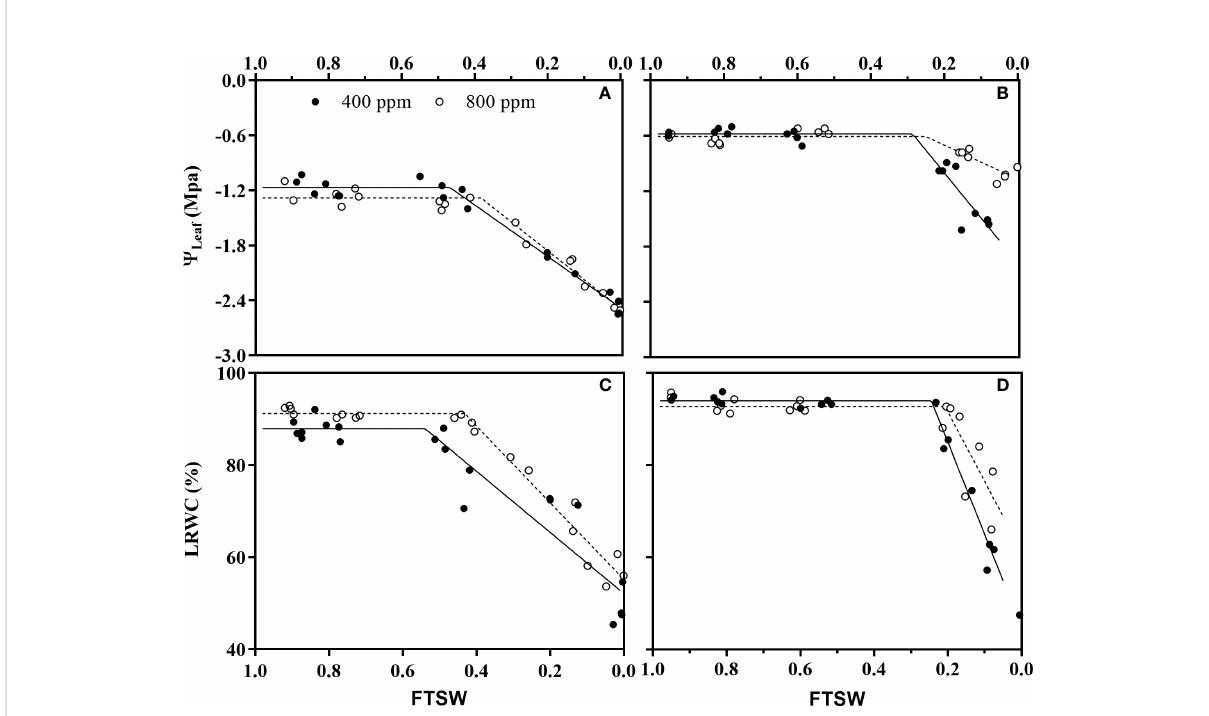
FIGURE 4 Changes of leaf water potential ( y Leaf ) of (A) wheat and (B) maize plants, and relative leaf water content (RLWC) of (C) wheat and (D) maize plants grown under ambient (400 ppm, a[CO 2 ]) and elevated (800 ppm, e[CO 2 ]) atmospheric CO 2 concentrations during progressive soil drying. Closed and open circles indicate plants at a[CO 2 ] and e[CO 2 ] concentration, respectively.